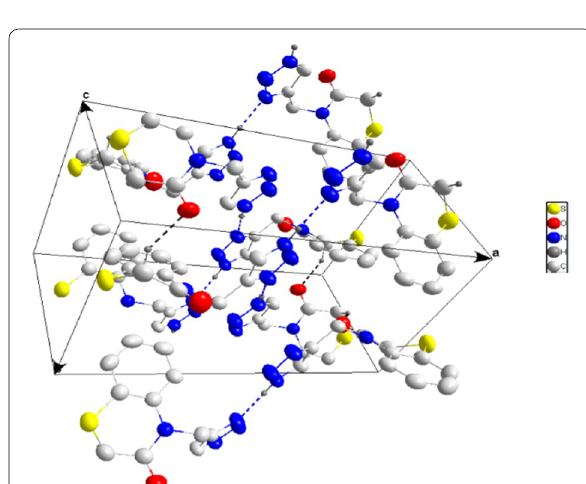
Fig. 4 Packing showing portions of the chains formed by N–H hydrogen bonds (blue dotted lines) and their association through C–H O hydrogen bonds (black dotted lines) of compound ···